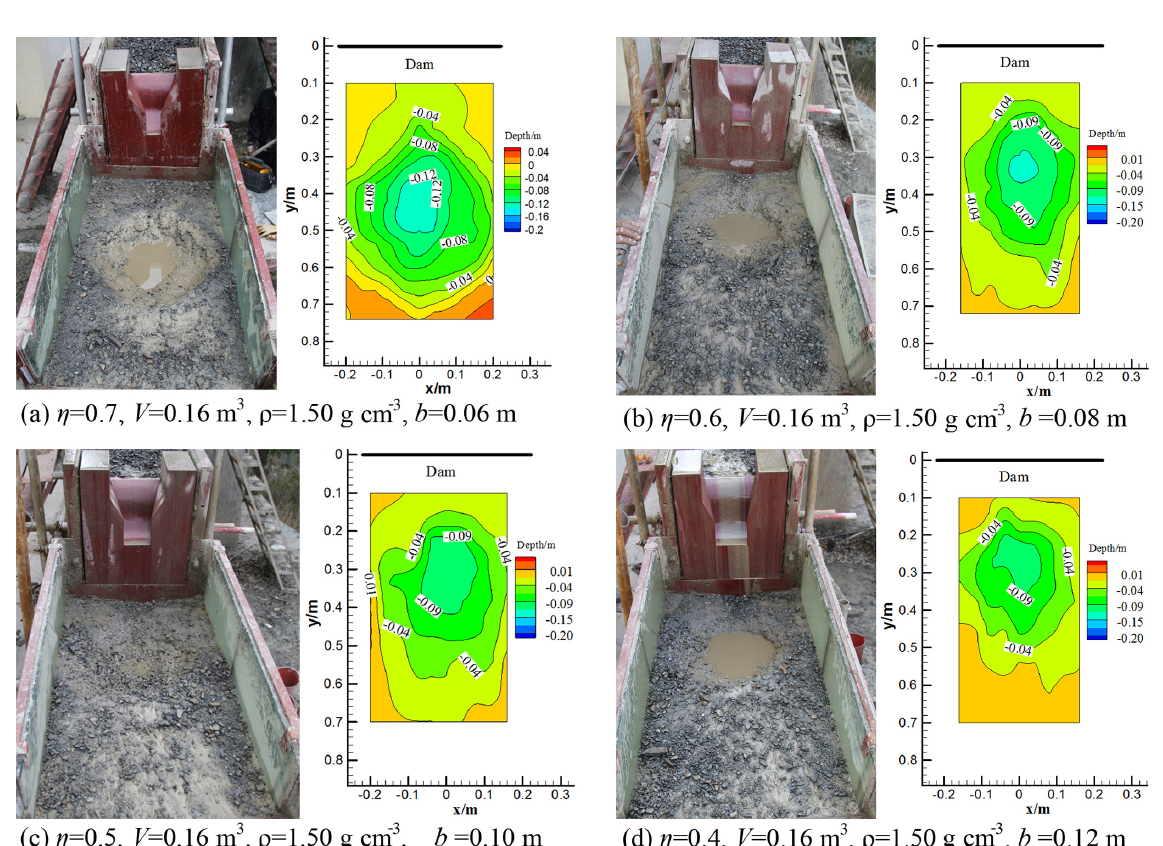
Figure 10. The shapes of the scour hole downriver of a check dam ( V = 0.16m 3 , ρ = 1.50gcm − 3